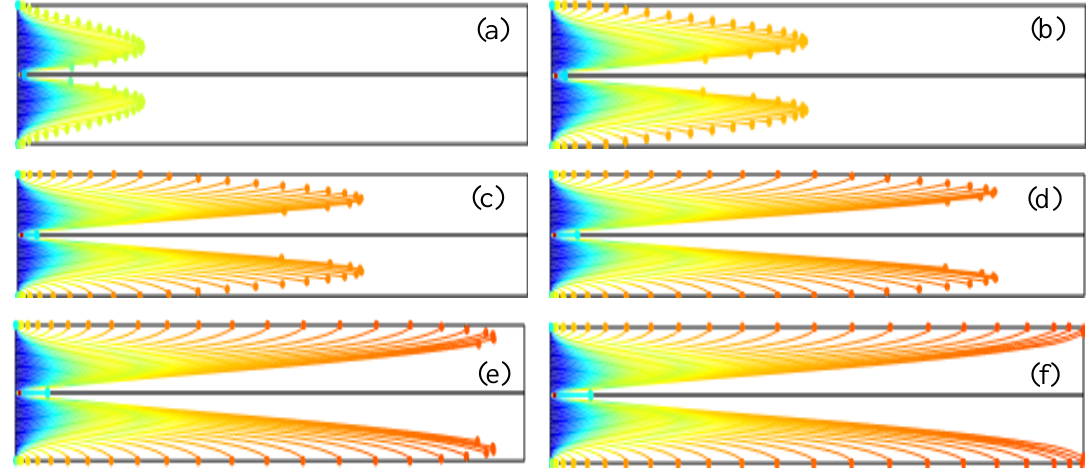
Figure 7: Time development of the particle trajectory for particles with a radius of